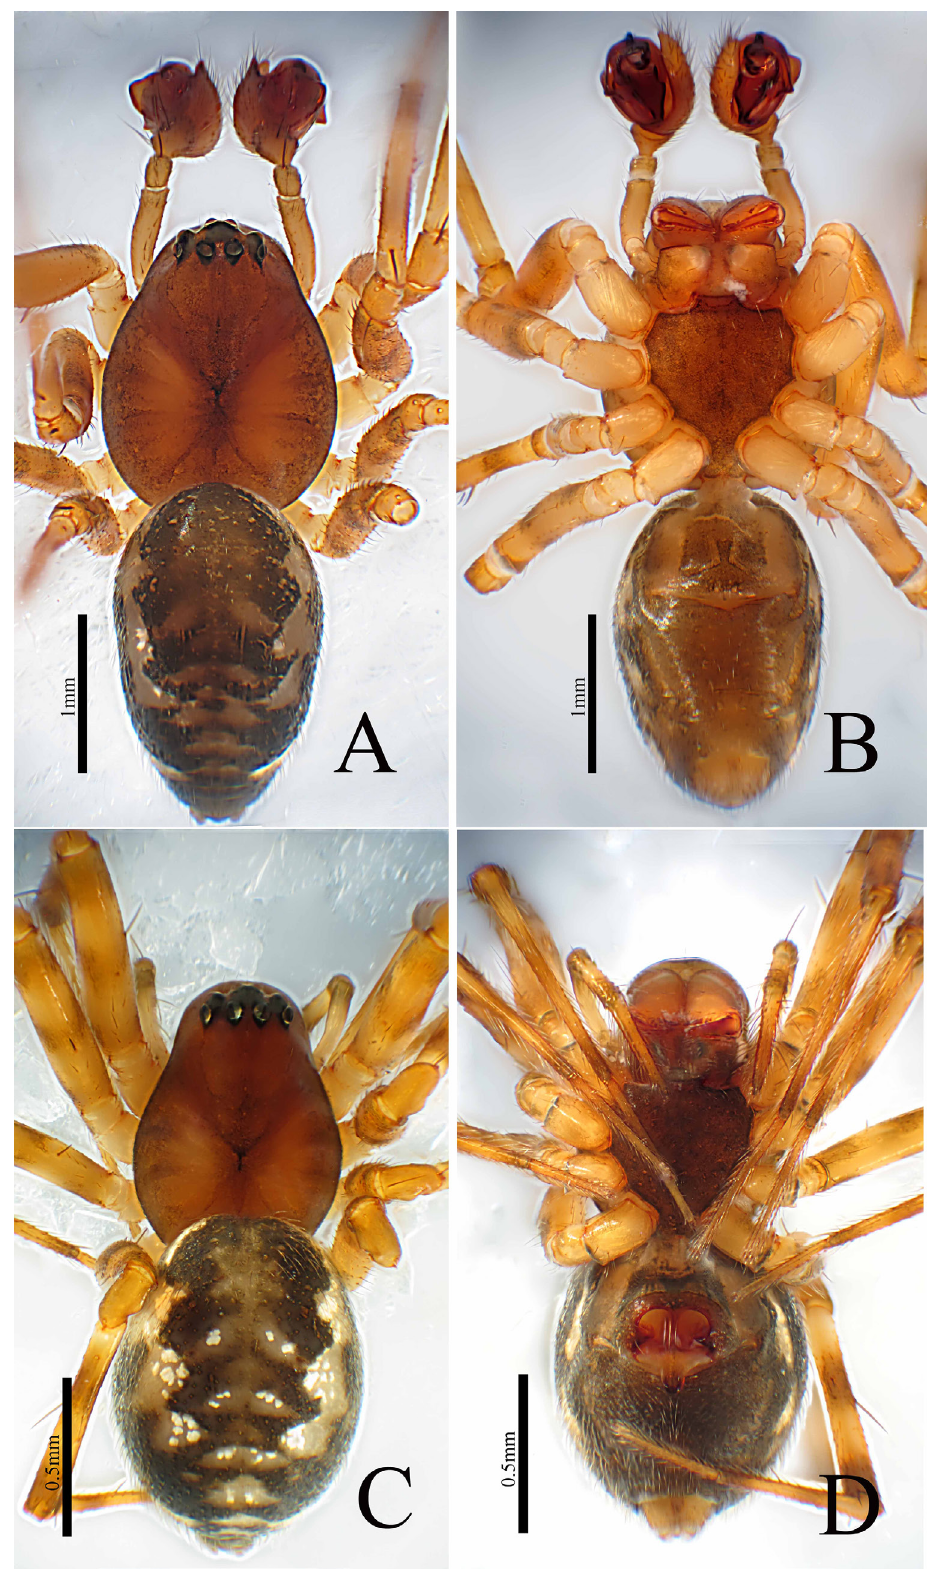
Fig. 14. Acroterius camur gen. et sp. nov. A–B . ♂, holotype (HNU-DHK–2002–038). C–D . ♀, paratype (HNU-DHK–2002–038). A , C . Habitus, dorsal view. B , D . Habitus,